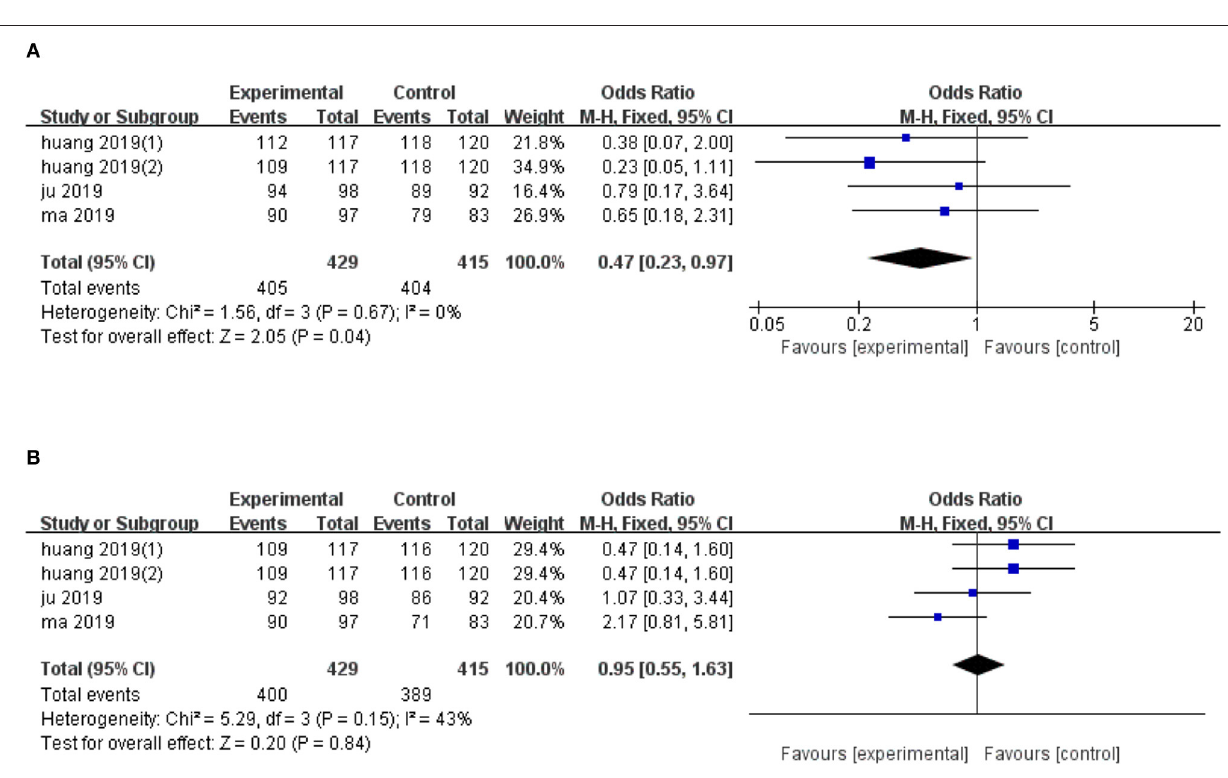
FIGURE 5 | Forest plot of the effects of ultrasonic image fusion on overall survival. (A) 1-year OS and (B) 2-year